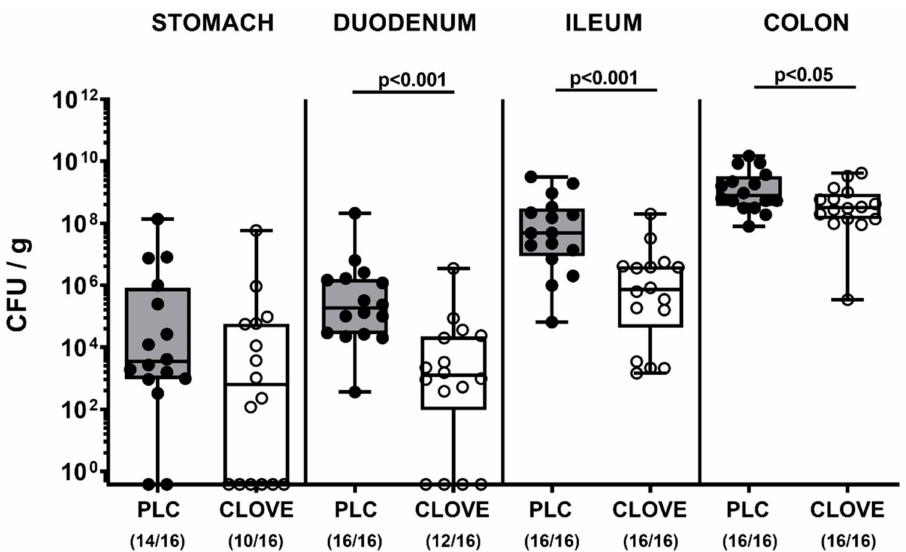
Figure 2. Gastrointestinal pathogen burdens following clove EO treatment of C. jejuni infected IL-10 − / − mice. Microbiota- depleted IL-10 − / − mice were perorally infected with C. jejuni strain 81-176 on day (d) 0 and d1. From d2 until d6 post-infection, mice were perorally challenged with clove EO or received placebo (PLC) via drinking water. On d6 post- infection, the pathogen numbers were determined in luminal samples taken from distinct gastrointestinal parts by culture and expressed as colony forming units per g, CFU/g). Box plots indicate the 75th and the 25th percentiles of the median (black bar within box). The total range, significance levels ( p values) determined by the Mann–Whitney U test and the number of pathogen-positive out of the total number of analyzed samples (in parentheses) are given. Data were pooled from four independent